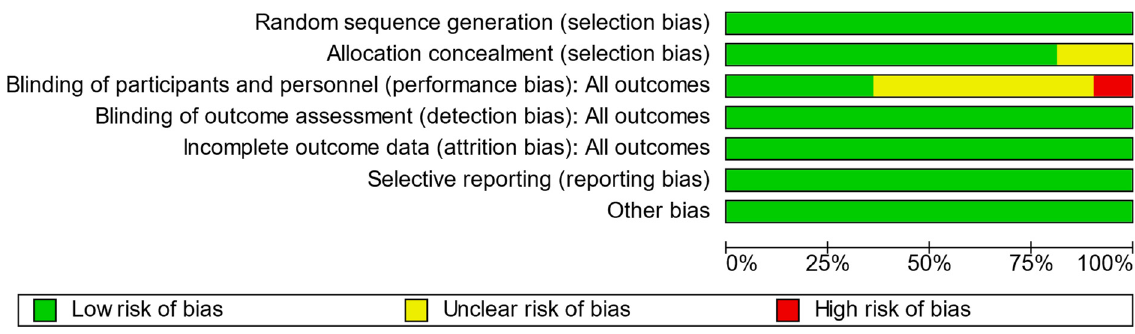
Figure 3. Overview of risk of bias amongst included articles. Table 2. Summary of quality assessments for individual articles included in the systematic review.